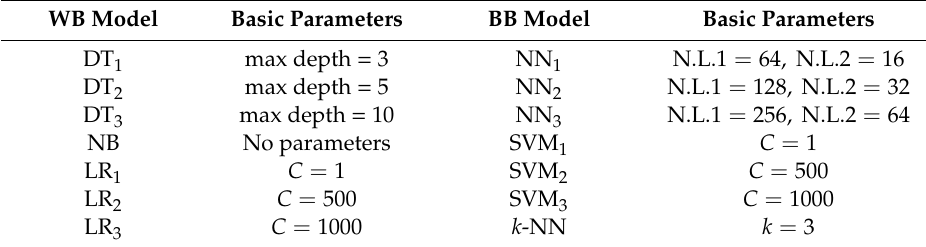
Table 5. Summary of utilized machine learning